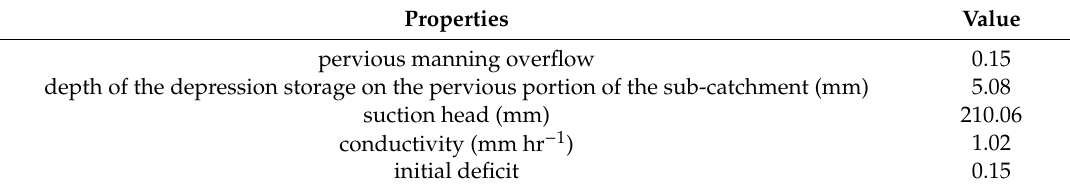
Table 3. Parameters of G i (greenbelt in IGRS).